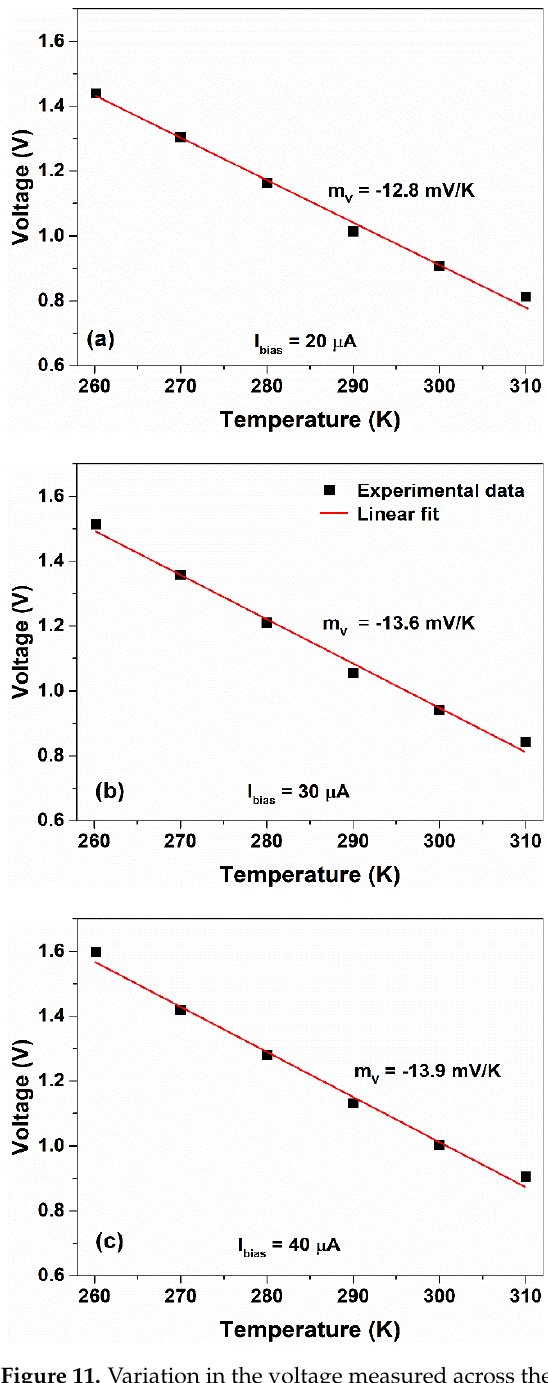
Figure 11. Variation in the voltage measured across the sensor as a function of the temperature for bias current values of ( a ) 20 μ A, ( b ) 30 μ A and ( c ) 40 μ A, respectively. The red solid lines represent the linear fit.